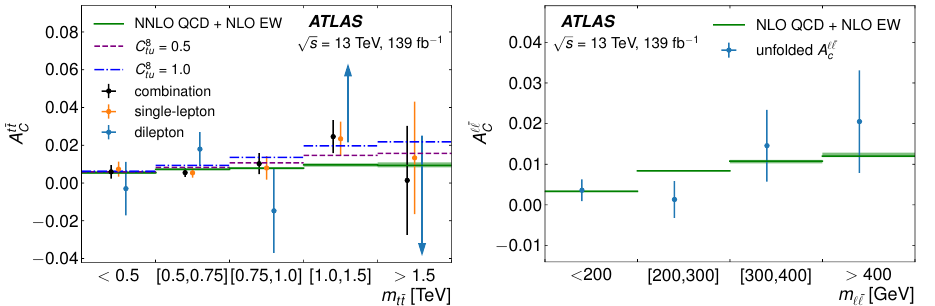
Figure 23. A t ¯ t asymmetry as a function of m t ¯ t ( left ) and A (cid:96)(cid:96) asymmetry as a function of m (cid:96)(cid:96) ( right ) C C from the unfolded distributions [60]. For A t ¯ t , the impact of a relevant Effective Field Theory coefficient C for two different values is also shown. For the A t ¯ t dilepton measurement, the central points for the C two last bins is outside the range of the